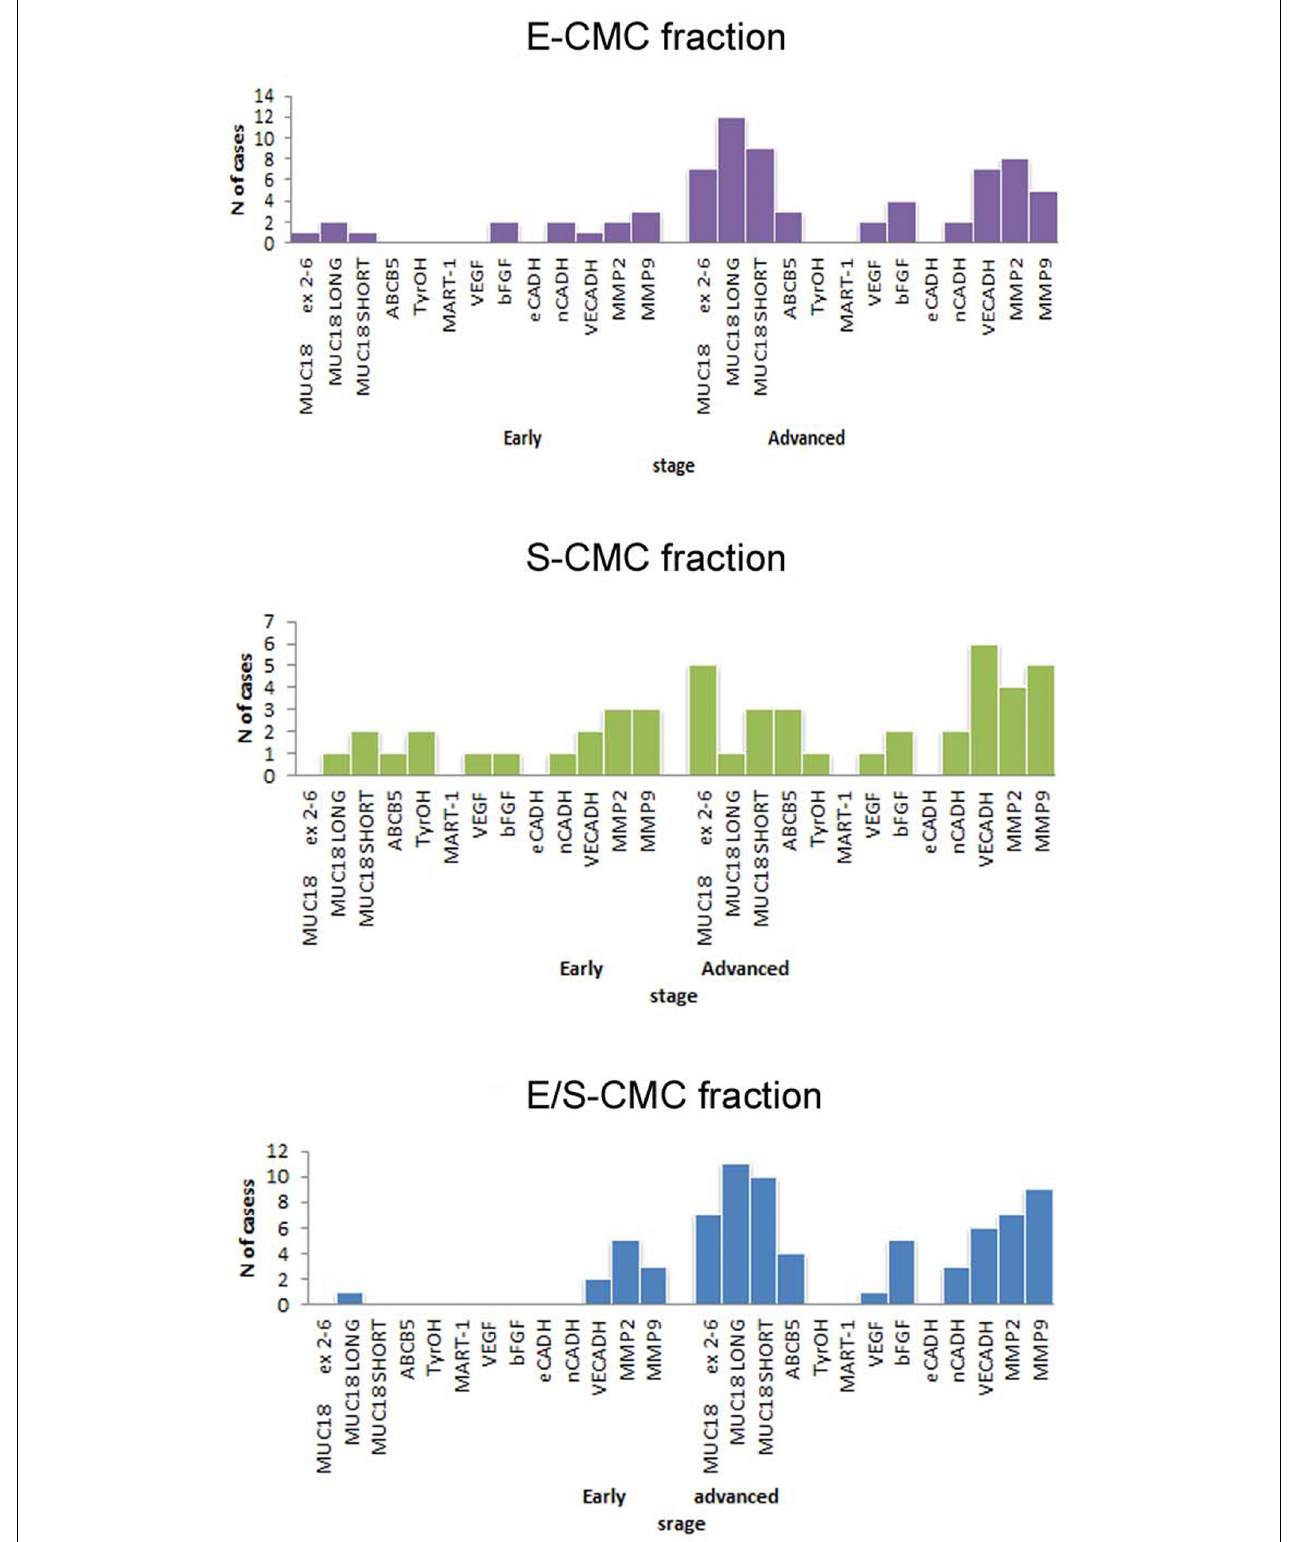
FIGURE 1 | Bar graphs showed the distribution of analyzed genes in subpopulations selected for this study. Distribution of cases considering positivity status of all biomarker analyzed in the three different subpopulations (early: I–II AJCC-staged eight patients; advanced: III–IV AJCC -staged 13 patients).